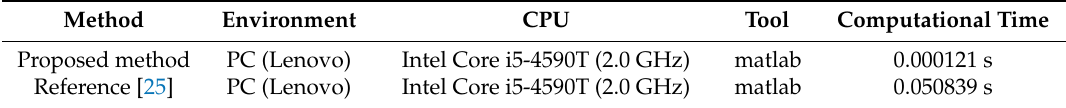
Table 3. Computational efficiency of proposed method and the method in reference [25].